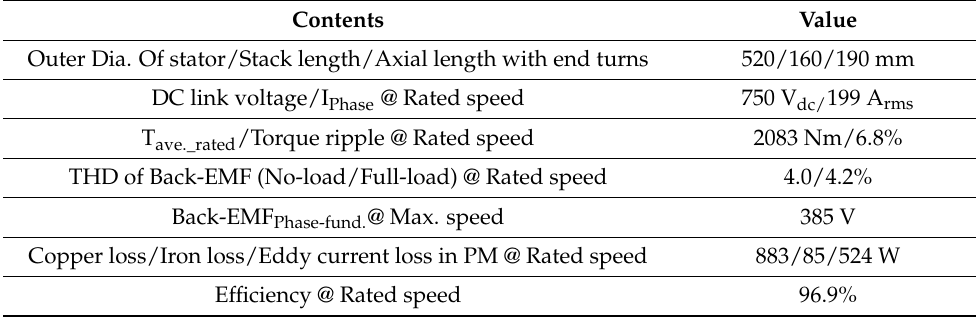
Table 6. Derivation results of the Detailed Design Model of 45kW-class MG-PMSM with